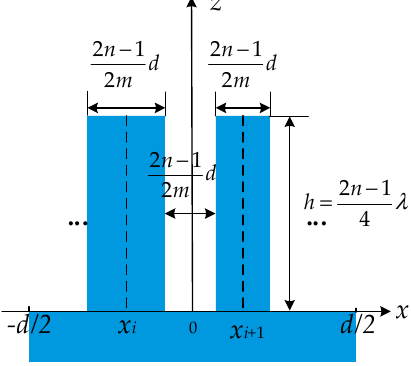
Figure 6. Segmented grating structure with the odd order m enhanced.